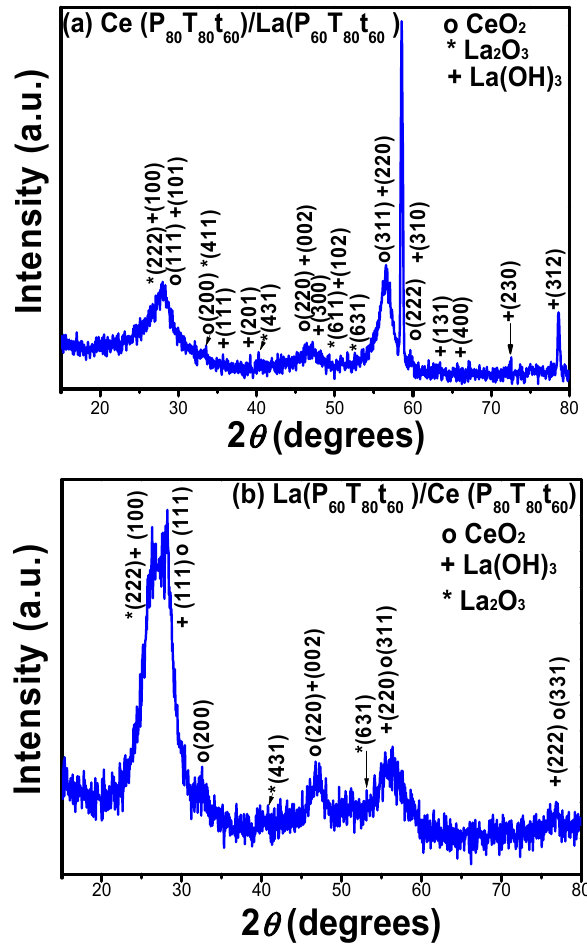
Figure 8. XRD of RE oxide bilayered coatings: ( a ) Ce( P 80 T 80 t 60 )/La( P 60 T 80 t 60 ) and, ( b ) La( P 60 T 80 t 60 )/Ce( P 80 T 80 t 60 ) onto Si (100) substrates.